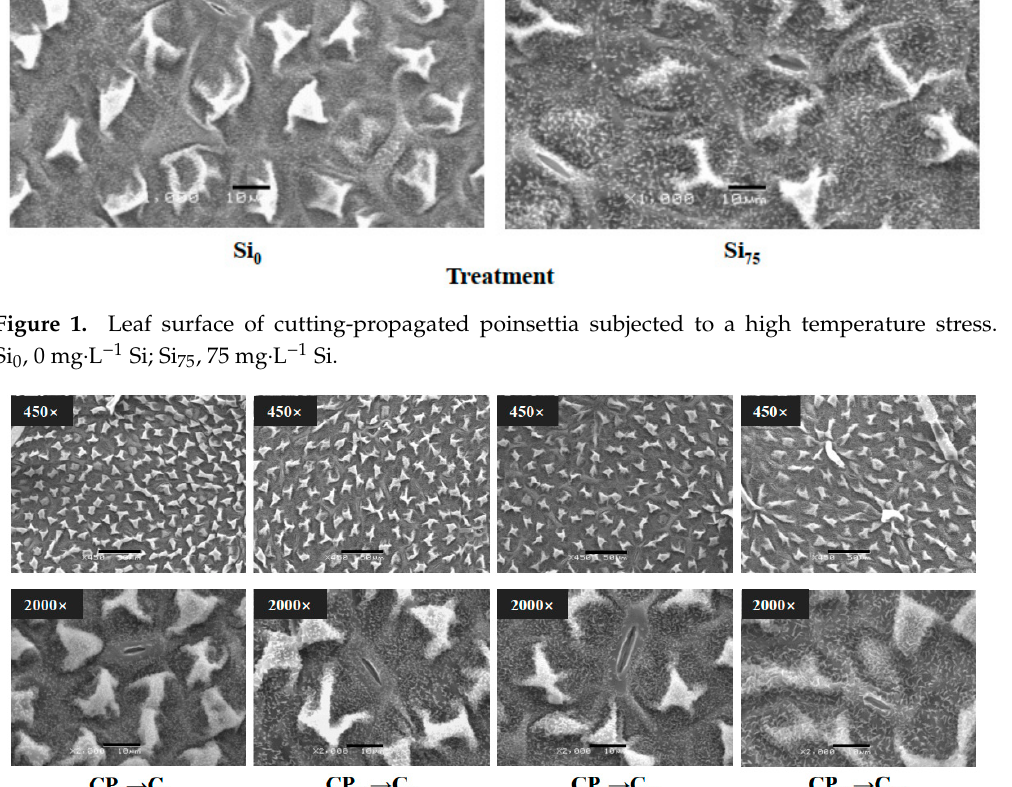
Figure 2. Leaf surface of potted poinsettia subjected to a low temperature stress. CP 0 → C 0 , grown with 0 mg ∙ L − 1 Si during cutting propagation and cultivation; CP 75 → C 0 , grown with 75 mg ∙ L − 1 Si during cutting propagation and 0 mg ∙ L − 1 Si during cultivation; CP 0 → C 75 , grown with 0 mg ∙ L − 1 Si during cutting propagation and 75 mg ∙ L − 1 Si during cultivation; CP 75 → C 75 , grown with 75 mg ∙ L − 1 Si during cutting propagation and 75 mg ∙ L − 1 Si during cultivation.